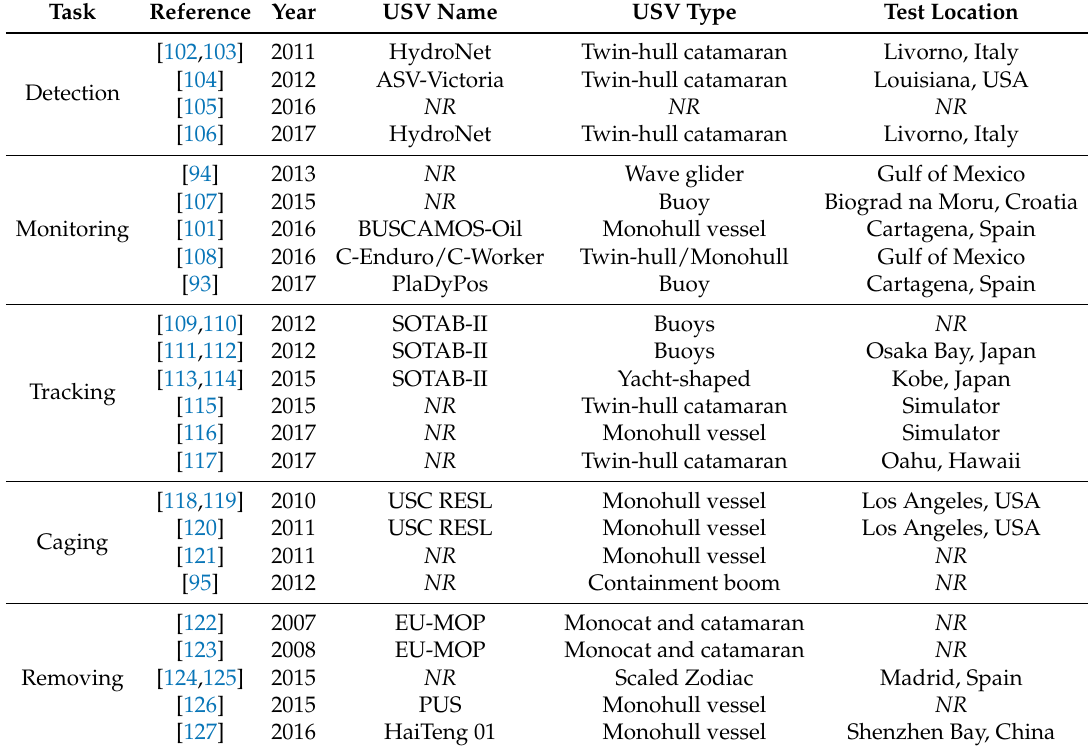
Table 3. Characteristics of work related to chemical hazards grouped by task, where “NR” stands for “Not